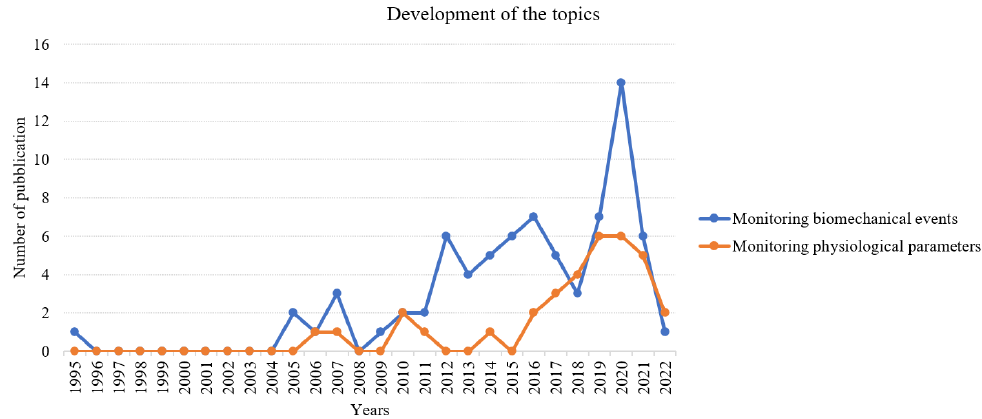
Figure 5. Development of the topics through the